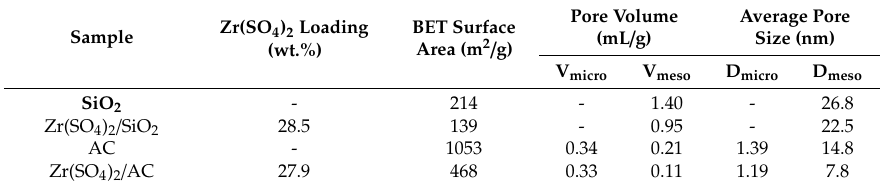
Table 1. Zr(SO 4 ) 2 loadings and textural properties of SiO 2 , Zr(SO 4 ) 2 / SiO 2 , AC, and Zr(SO 4 ) 2 / AC samples. Pore Volume Average Pore BET Surface Sample Zr(SO 4 ) 2 Loading (mL / g) Size Area (m 2 / g) (wt.%)